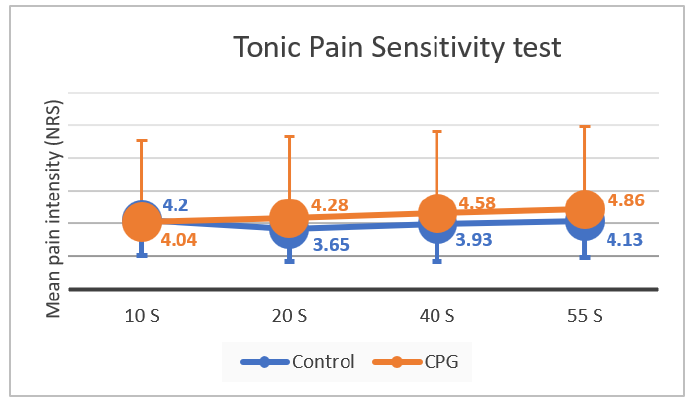
Figure 5. Intensity of pain perception throughout the tonic stimulus (10, 20, 40, and 55 s) in the control group and in the CPG, with standard deviation bars (mean ± SD). NRS, numeric rating scale; SD, standard deviation; CPG, chronic pain group. There were no significant differences in NRS during the tonic stimulus between the control group and the CPG (Friedman test).